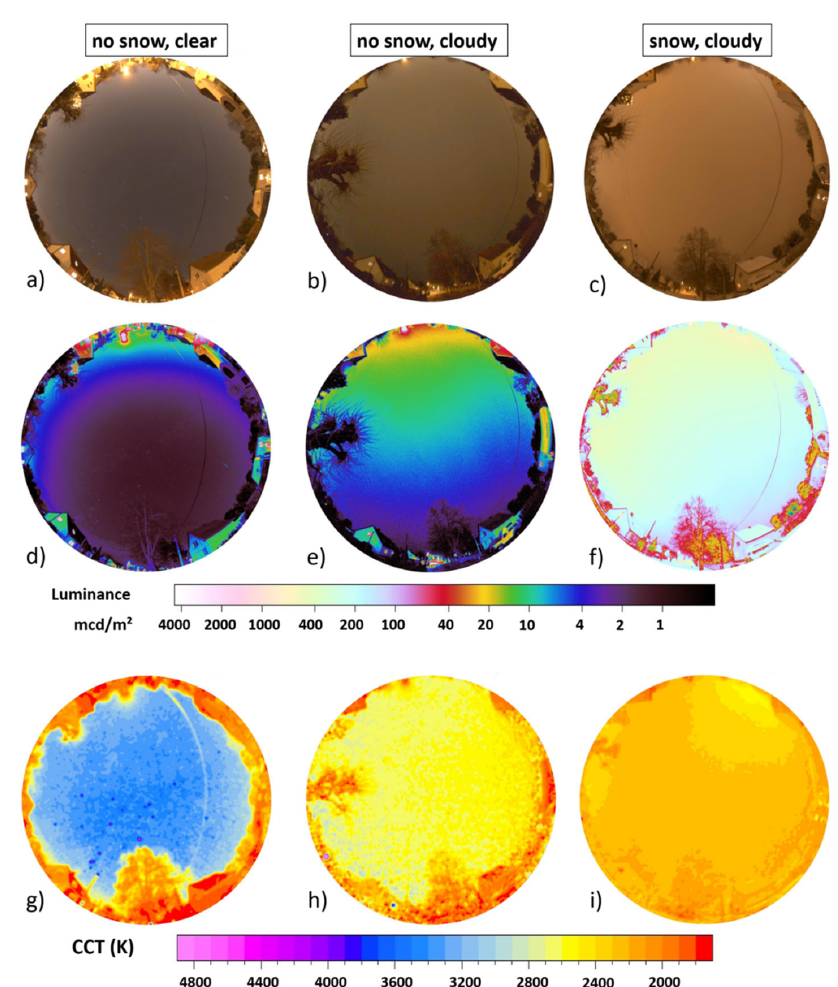
Figure 4. Imaging data taken during three winter nights in the suburban area in the town of Ludwigsfelde, Germany close to Berlin. Panels ( a – c ) show full-color RGB, panels ( d – f ) show luminance maps and panels ( g – i ) show CCT maps. The left column ( a , d , g ) shows data from a clear night without snow, middle column ( b , e , h ) shows data from an overcast night without snow and right column ( c , f , i ) shows data from an overcast night with freshly fallen snow.